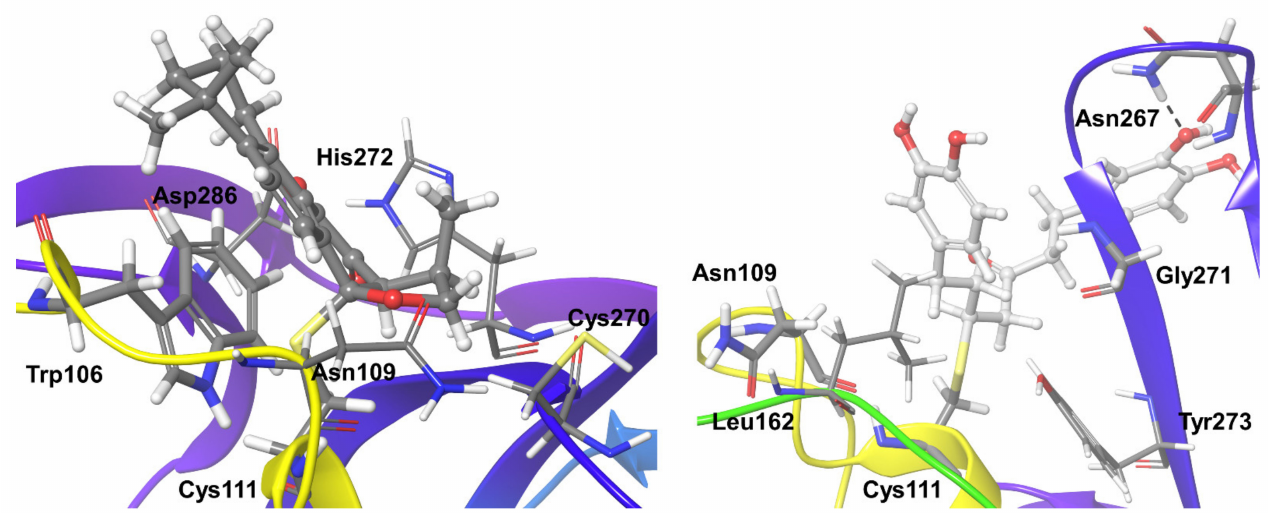
Figure 5. Stable interactions observed during MD simulations of Compound 3 ( left ) and 4 ( right ) with SARS-CoV-2 Plpro. The compounds are shown in ball and stick representation, stable and moderately stable interacting protein residues are given as thick tubes, and weak interactions (for less than 30%) are represented as thin